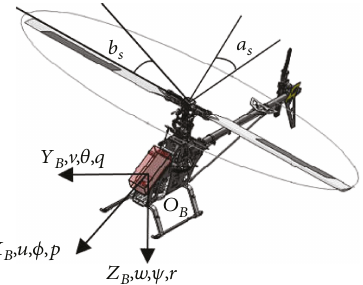
Figure 1: Illustration for the helicopter and